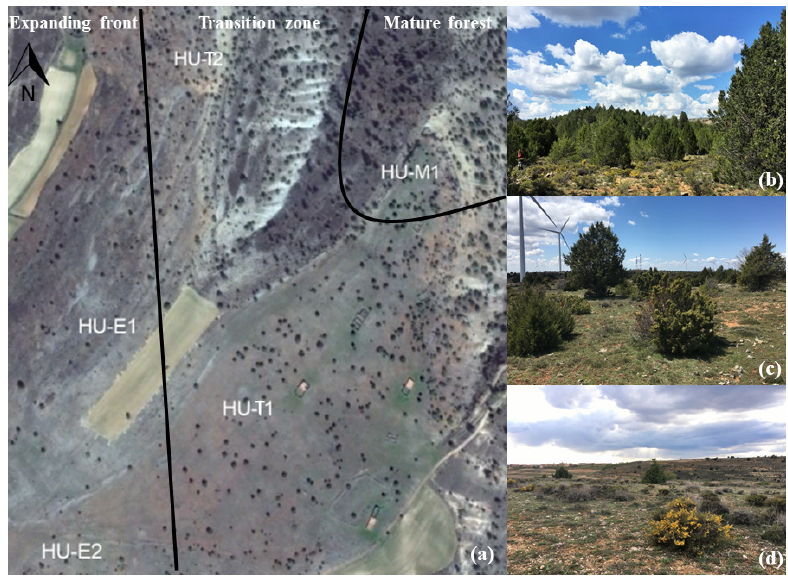
Figure 1. ( a ) Satellite image of Juniperus thurifera (L.) forest expansion gradient at the Huertahernando site. Black lines separate different stages of the gradient. From left to right: the expanding front (HU-E1 and HU-E2), transition zone (HU-T1 and HU-T2), and the mature forest (HU-M1). Images of different stages on field: the mature forest ( b ), transition zone ( c ), and the expanding front ( d ).